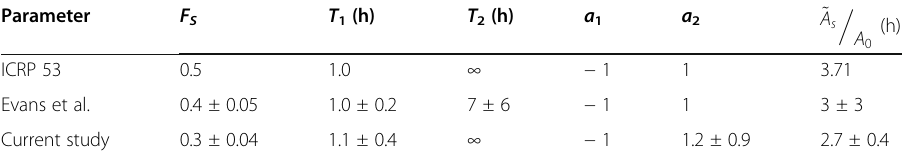
Table 5 Comparison of Tc-99m DMSA model parameters (± standard deviations) for the kidneys Parameter F